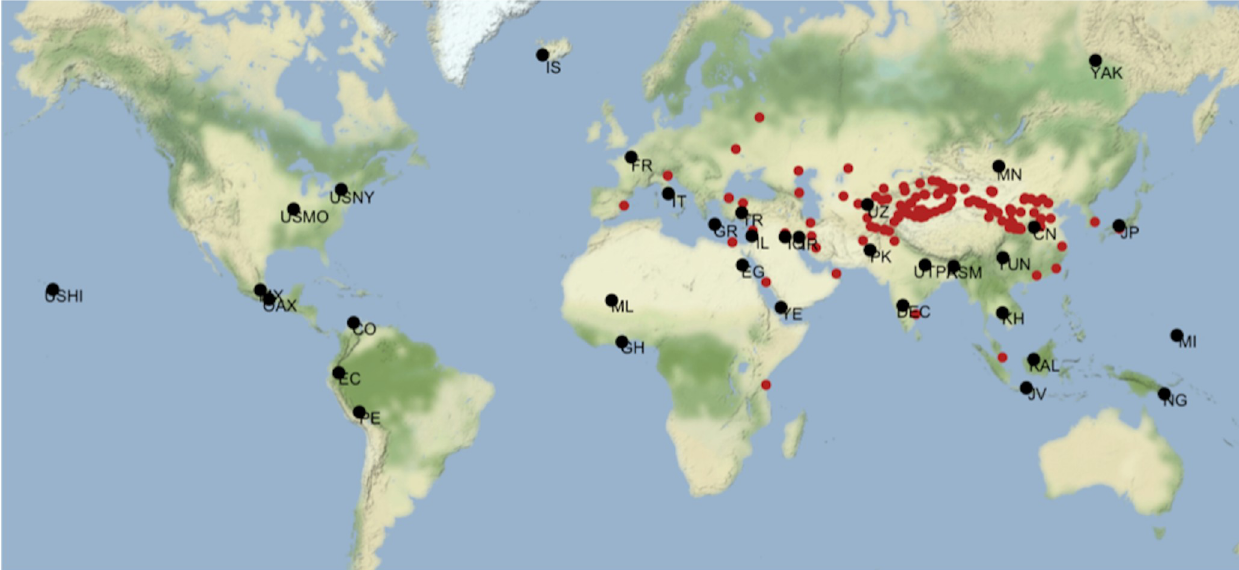
Fig 1. Location of nodes on Silk Routes used in quantifying Centrality (red) along with NGA locations (black).